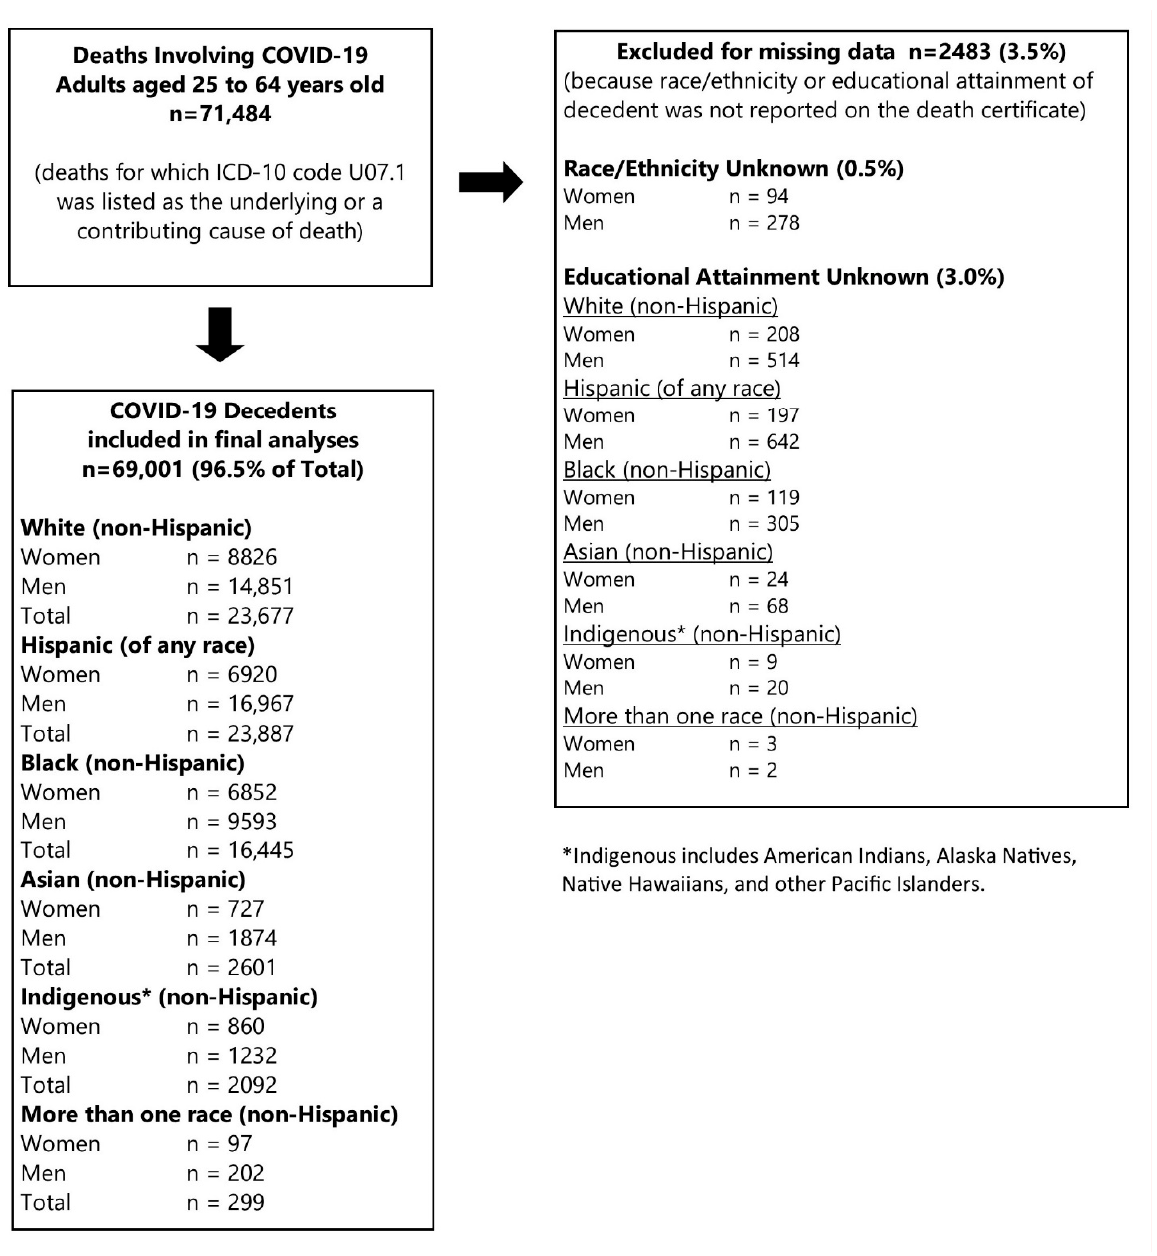
Figure 1. Study Inclusion of Deaths Involving COVID ‐ 19 in Adults Aged 25–64 Years Old, United